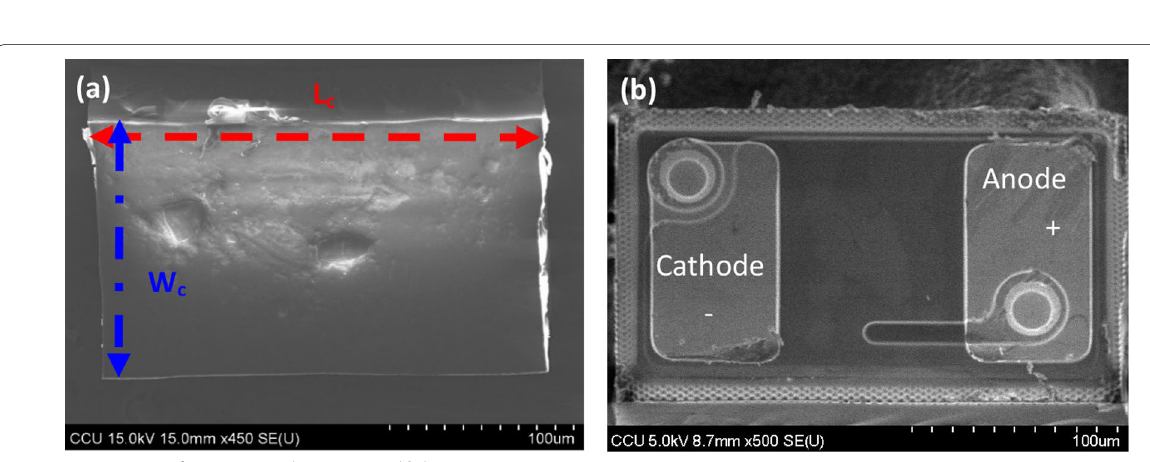
Fig. 7 SEM images of micro‑LEDs chip: a top and b bottom